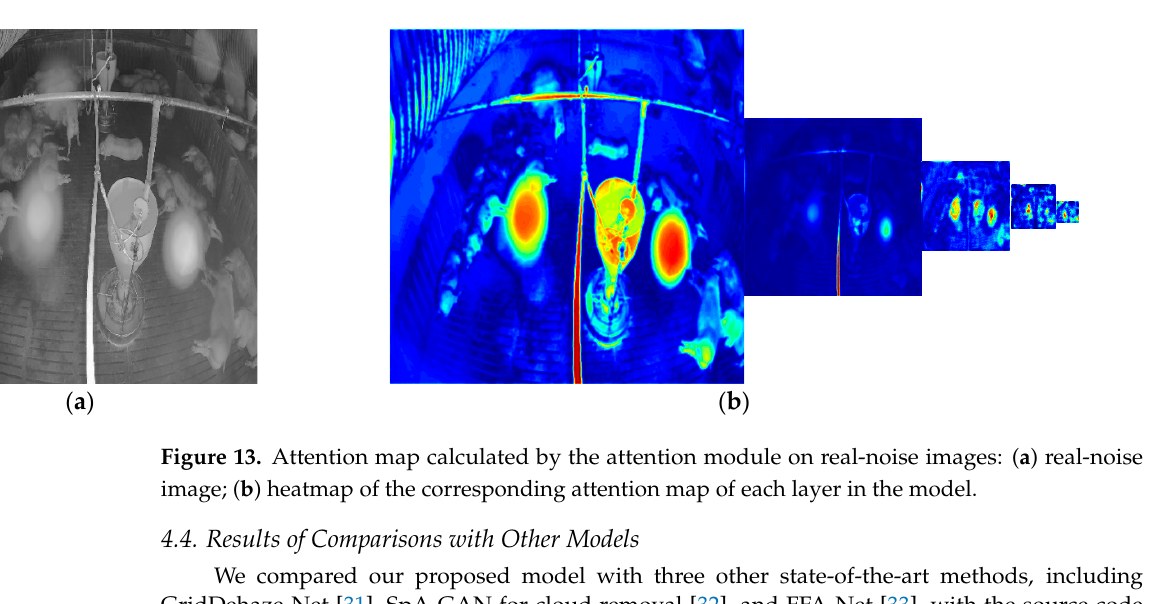
Figure 12. Attention map calculated by the attention module on simulated noisy images: ( a ) simulated noisy image; ( b ) heatmap of the corresponding attention map of each layer in the model.